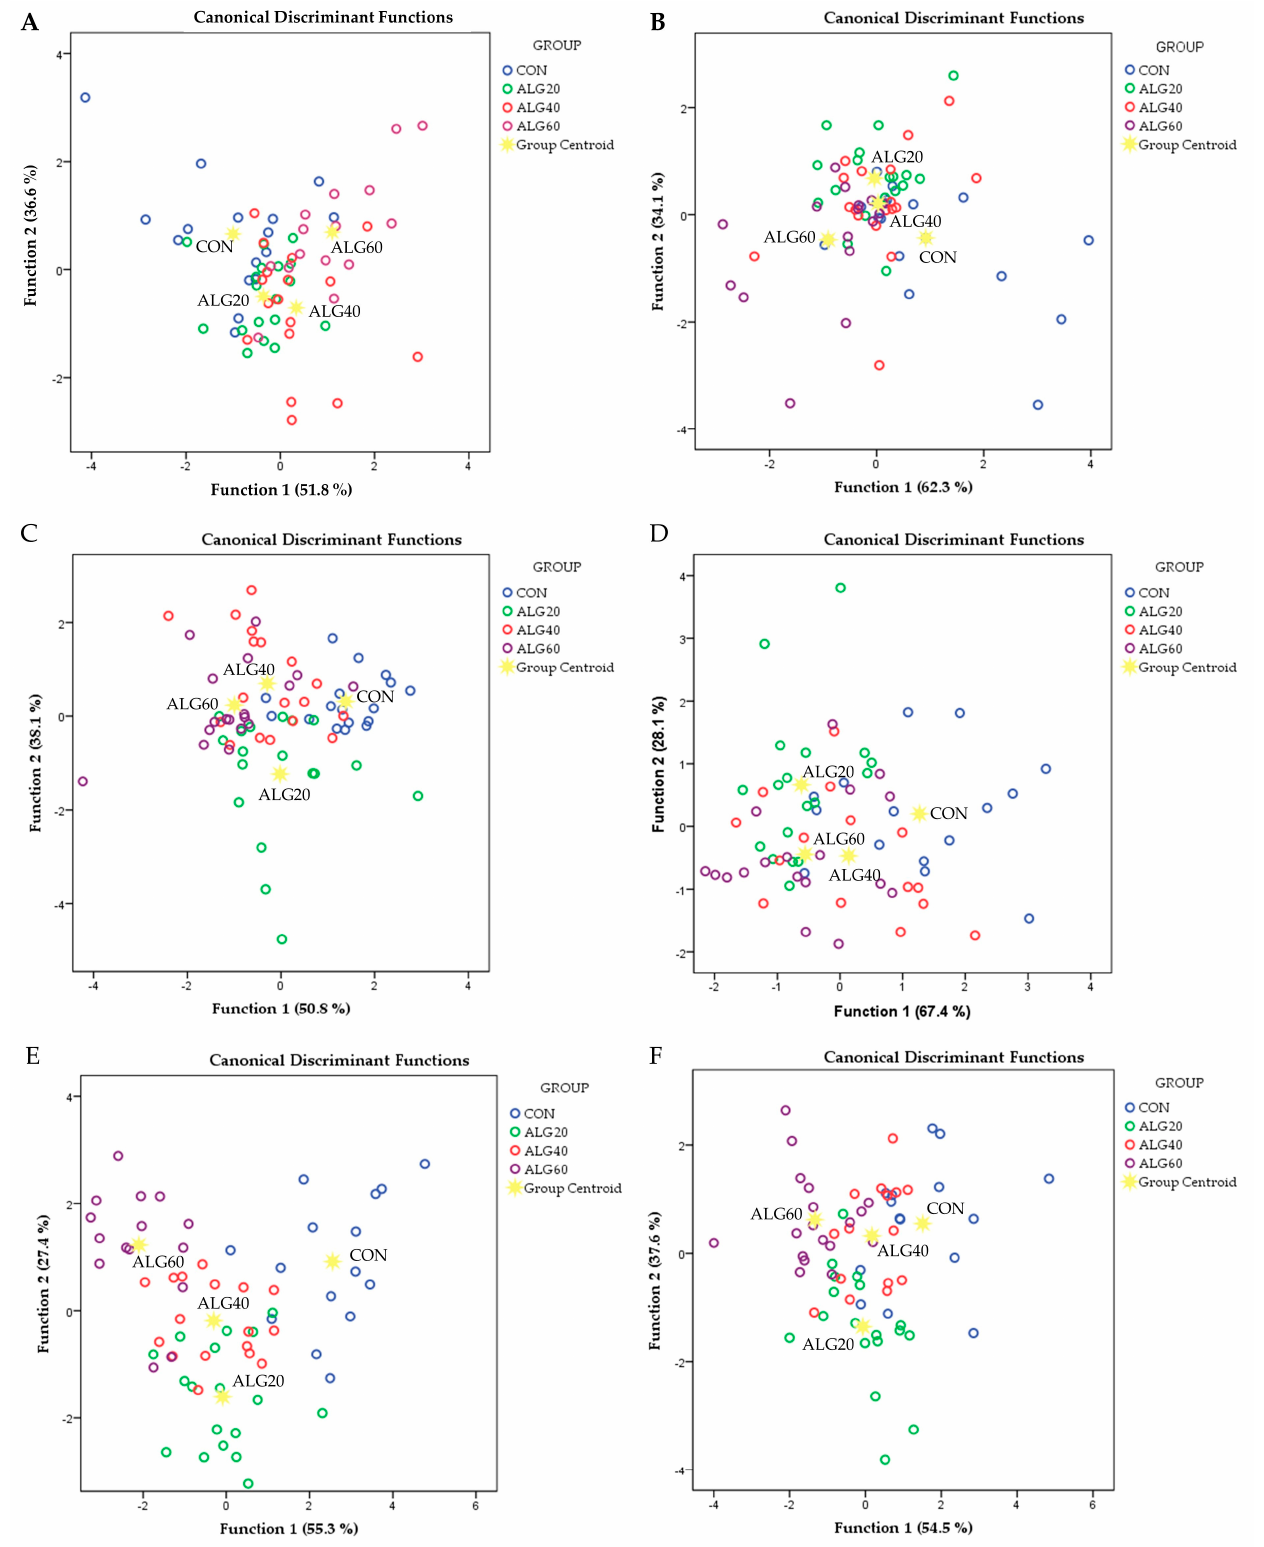
Figure 3. Discriminant plots separating the four dietary treatments (CON, ALG20, ALG40 and ALG60) according to ( A ) monocytes antioxidants and pro-oxidants genes, ( B ) monocytes immune-regulation genes ( C ) neutrophils antioxidants and pro-oxidants genes, ( D ) neutrophils immune-regulation genes, ( E ) monocytes and neutrophils antioxidants and pro-oxidants genes, and ( F ) monocytes and neutrophils immune ‐ regulation genes.